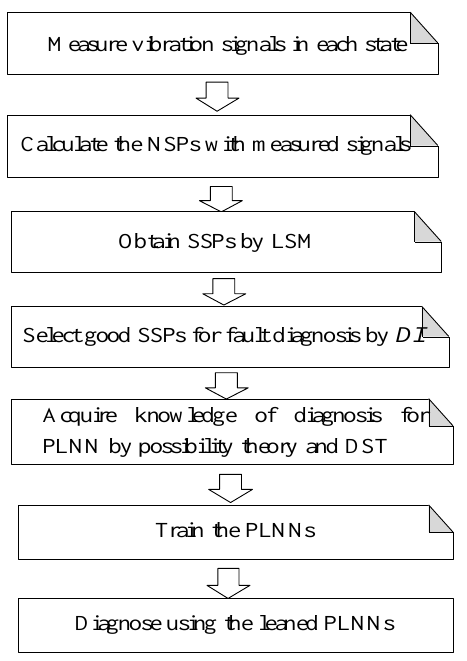
Figure 1. Flowchart of the condition